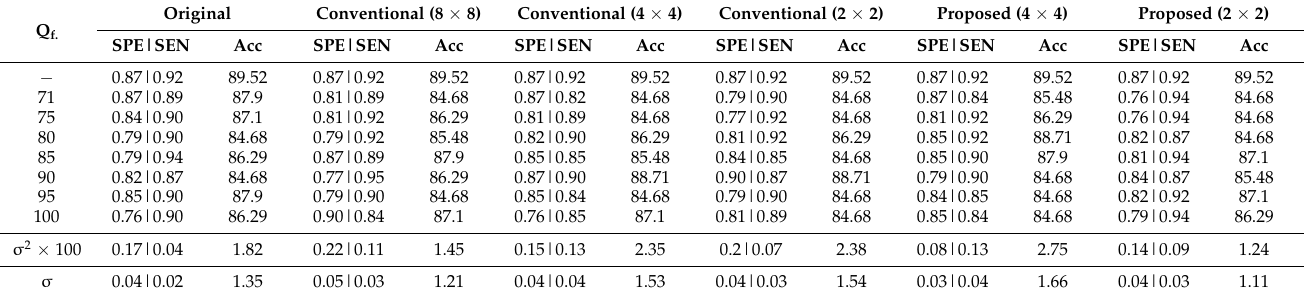
Table 7. Performance analysis of the proposed model in-terms of specificity (SPE) and sensitivity